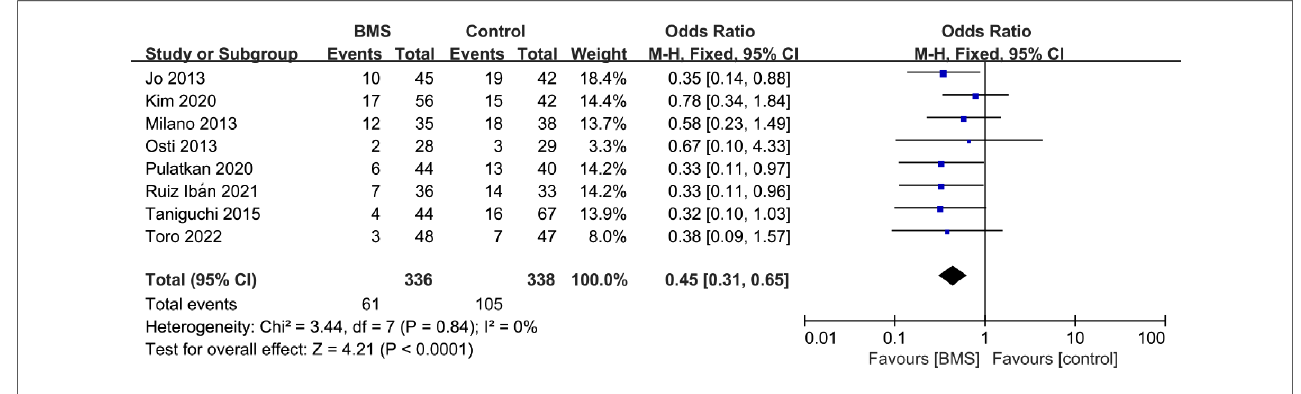
FIGURE 3 Forest plot of the incidence of retears in the BMS and control